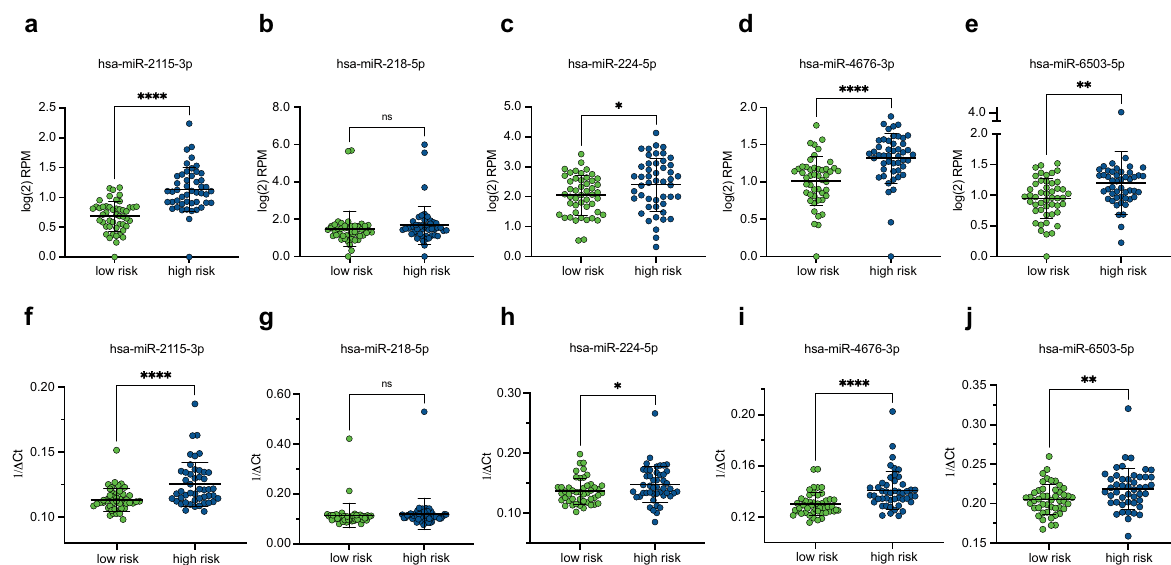
Fig. 3 miRisk miRNA expression in low-risk and high-risk patients. a – e Relative expression levels of the 5 miRisk miRNAs between low-risk and high-risk patients measured by small RNA sequencing. f – j Relative expression levels of the 5 miRisk miRNAs between low-risk and high- risk patients measured by qRT-PCR. The mean expression of triplicate measurements is shown. qRT-PCR expression was normalized according to the Δ Ct method (Ct miRNA of interest − Ct mean of HK miRNAs ). All statistical tests were two-tailed unpaired t tests. Error bars denote standard deviation. RPM reads per million. * p -value < 0.05, ** p -value < 0.005, *** p -value < 0.0005, **** p -value < 0.00005, ns not signi fi